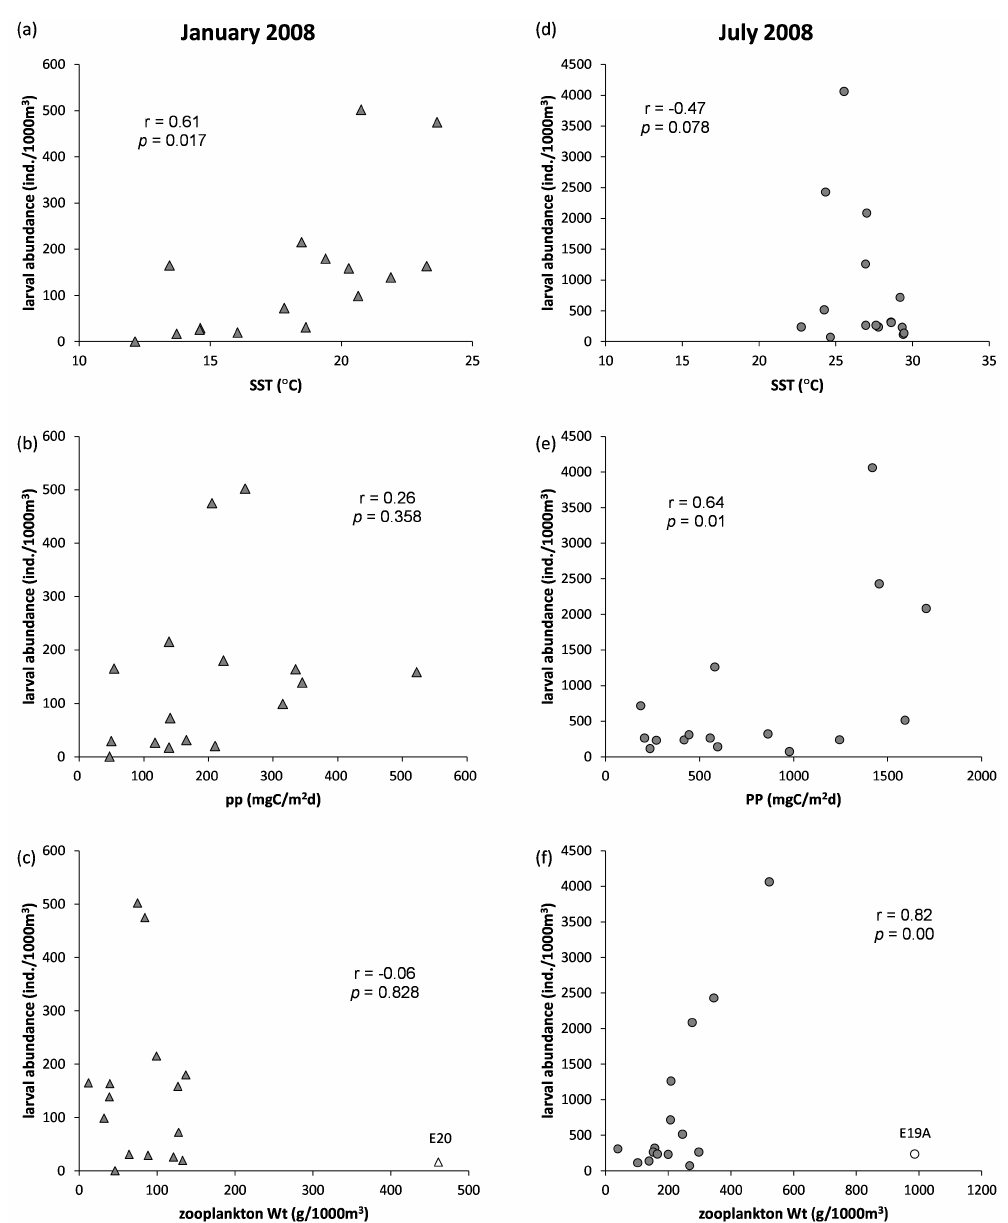
Fig. 6. Relationships between CPUE of larval fish and each of the environmental variables – sea surface temperature, primary production, and zooplankton wet